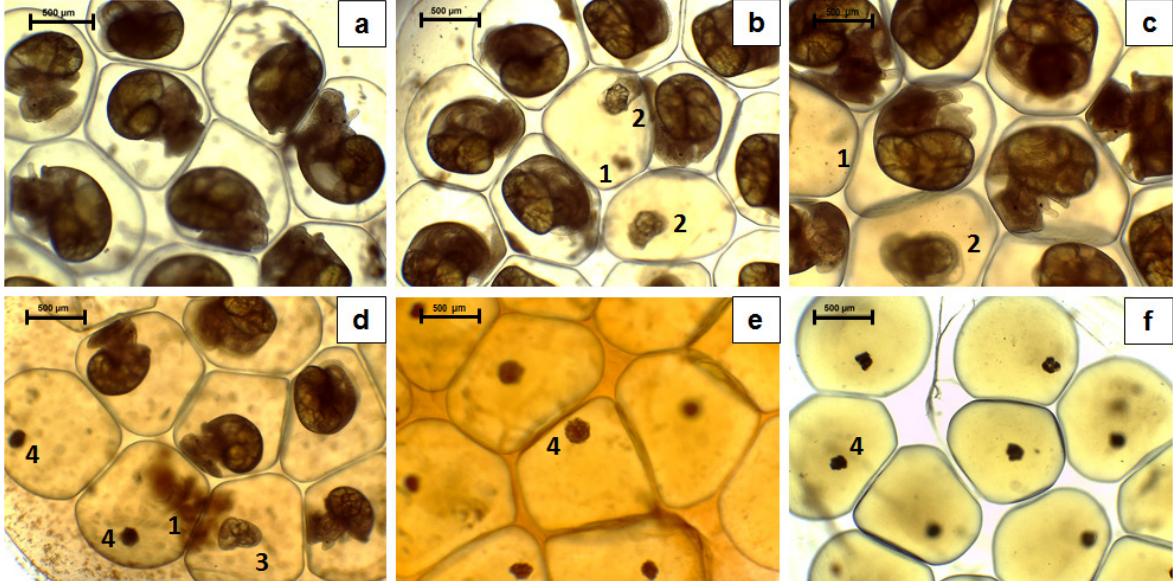
Figure 4. Morphological alterations and mortality of Biomphalaria glabrata embryos after exposure to the crude ethanolic extract of the Persea americana stem bark for 144 h. ( a ) Negative control (NC = reconstituted water). ( b ) Embryos exposed to 6.2 ppm. ( c ) Embryos exposed at 12.5 ppm. ( d ) Embryos exposed to 25 ppm. ( e ) Embryos exposed at 50 ppm. ( f ) Positive control (PC = niclosamide). (1) Coagulation of perivitelline substance. (2) Shell malformation. (3) Non-specific malformation. (4) Dead embryos. Magnification: 40 x . Scale: 500